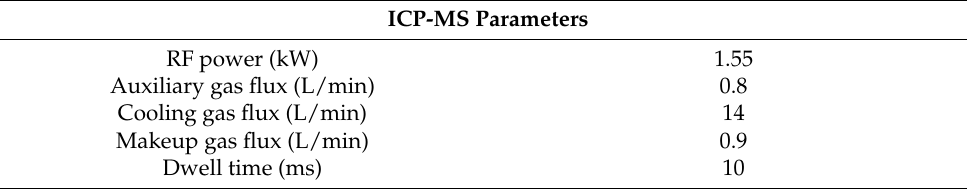
Table 3. ICP-MS operating parameters used for all the ICP-MS and LA-ICP-MS